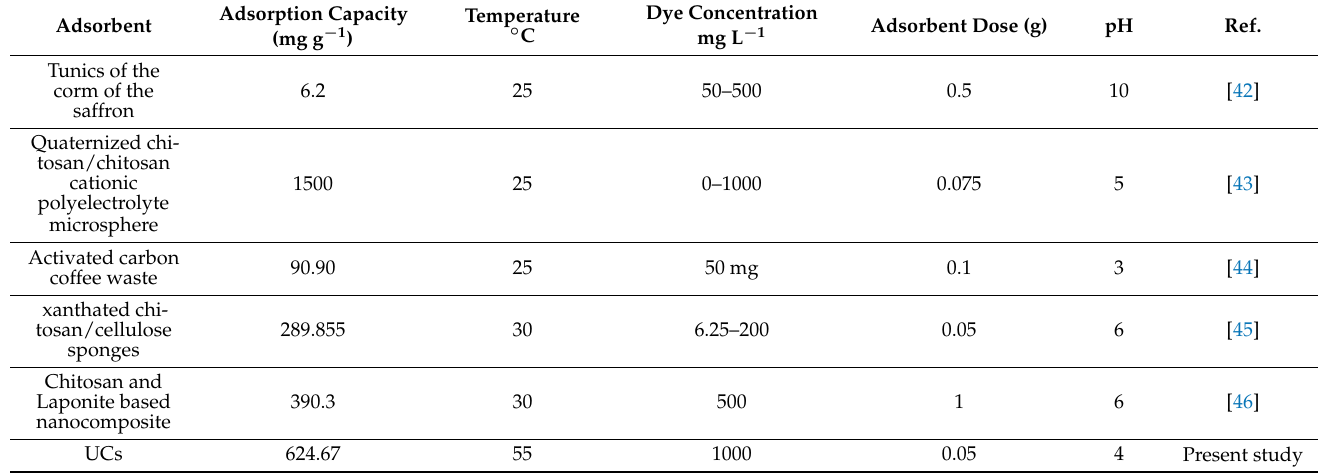
Table 9. Comparison of adsorption capacity of UCs with other adsorbents for the removal of CR dye.